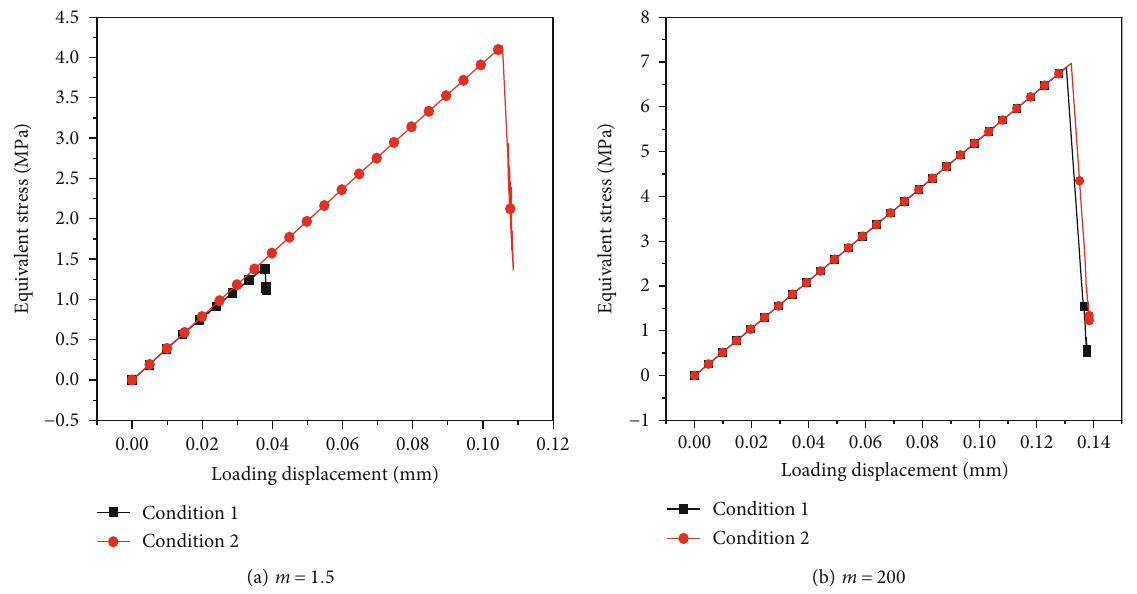
Figure 3: Equivalent stress-loading displacement curves of the Brazilian discs under di ff erent conditions. Table 2: Examples for reproducibility calculation. Model